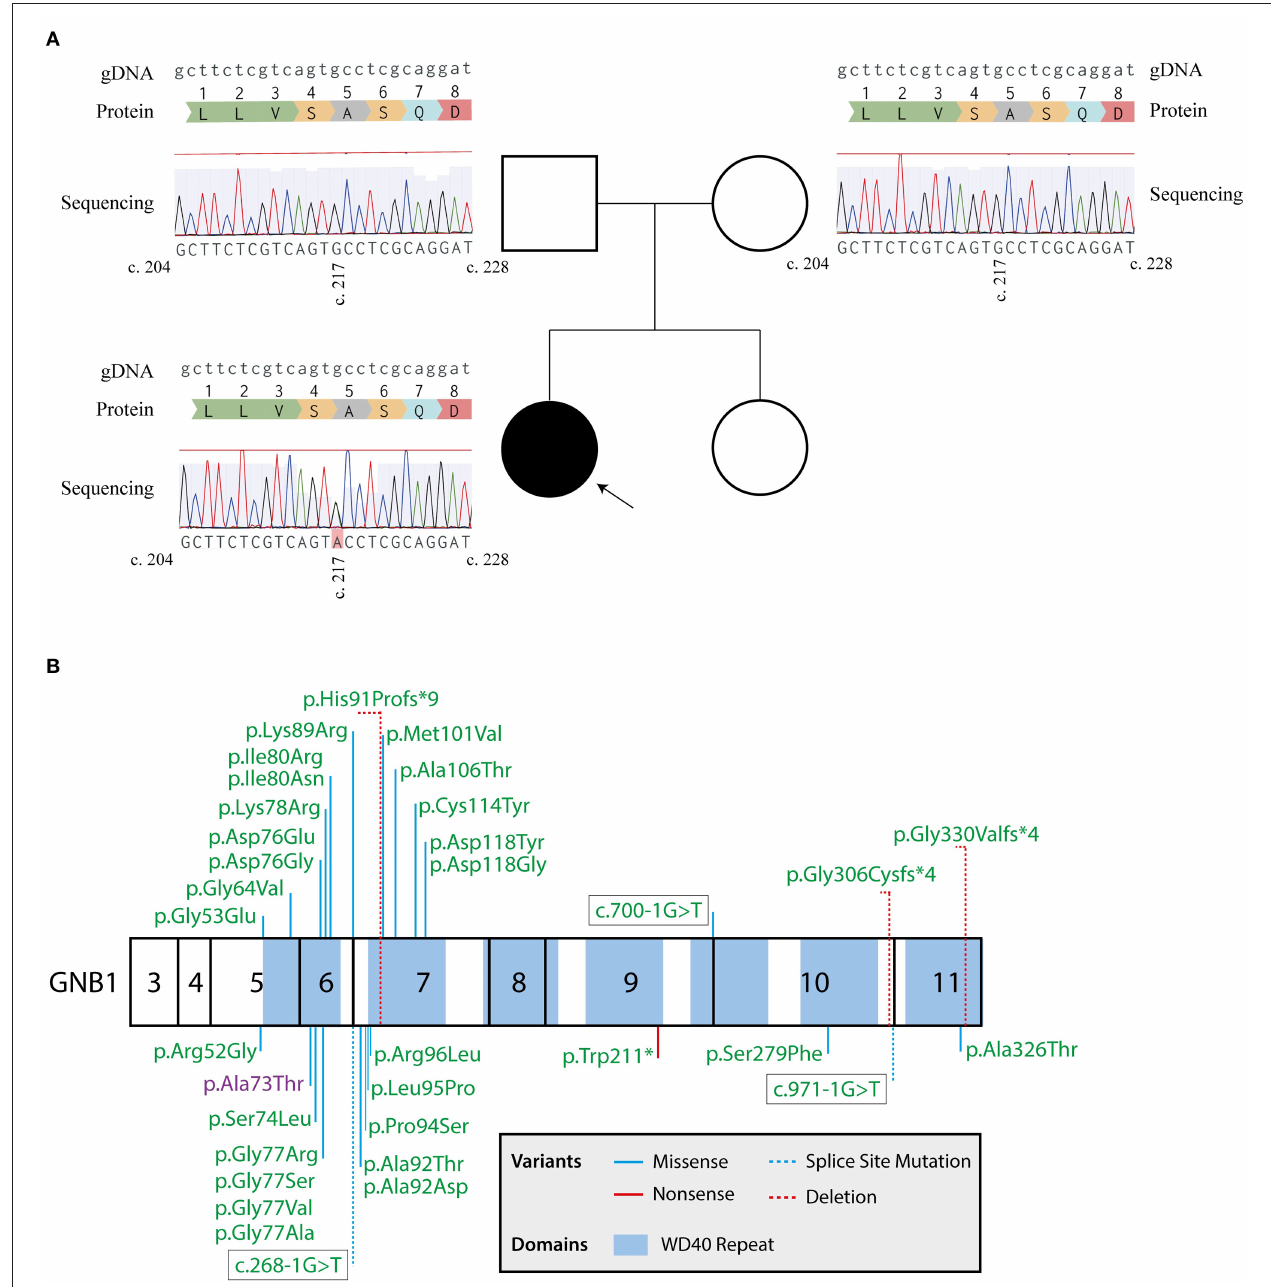
FIGURE 1 | Sanger sequencing confirms a de novo GNB1 variant. (A) Genogram of the proband with the respective results for GNB1 sequencing of the patient and each parent. The c.217G > A heterozygous mutation was detected in the proband but not in the parents, indicating a de novo occurring variant. Results from Sanger sequencing were aligned with the genomic GNB1 sequence (NG_047052.1) using the MAFFT 7 algorithm (20). The gDNA lane represents the genomic GNB1 sequence; the protein lane represents the translation of amino acids from GNB1 exon 6; the sequencing lane represents the results from Sanger sequencing of each patient, with a c.217G > A variant in the proband. (B) Mutation map of all GNB1 variants implicated in GNB1 encephalopathy to the date of the study. Numbers inside each box represent the translated exons of GNB1 (exons 1, 2, and 12 are not translated). Whenever possible, the mutation is represented by the change in protein structure. The variant detected in the patient is highlighted in